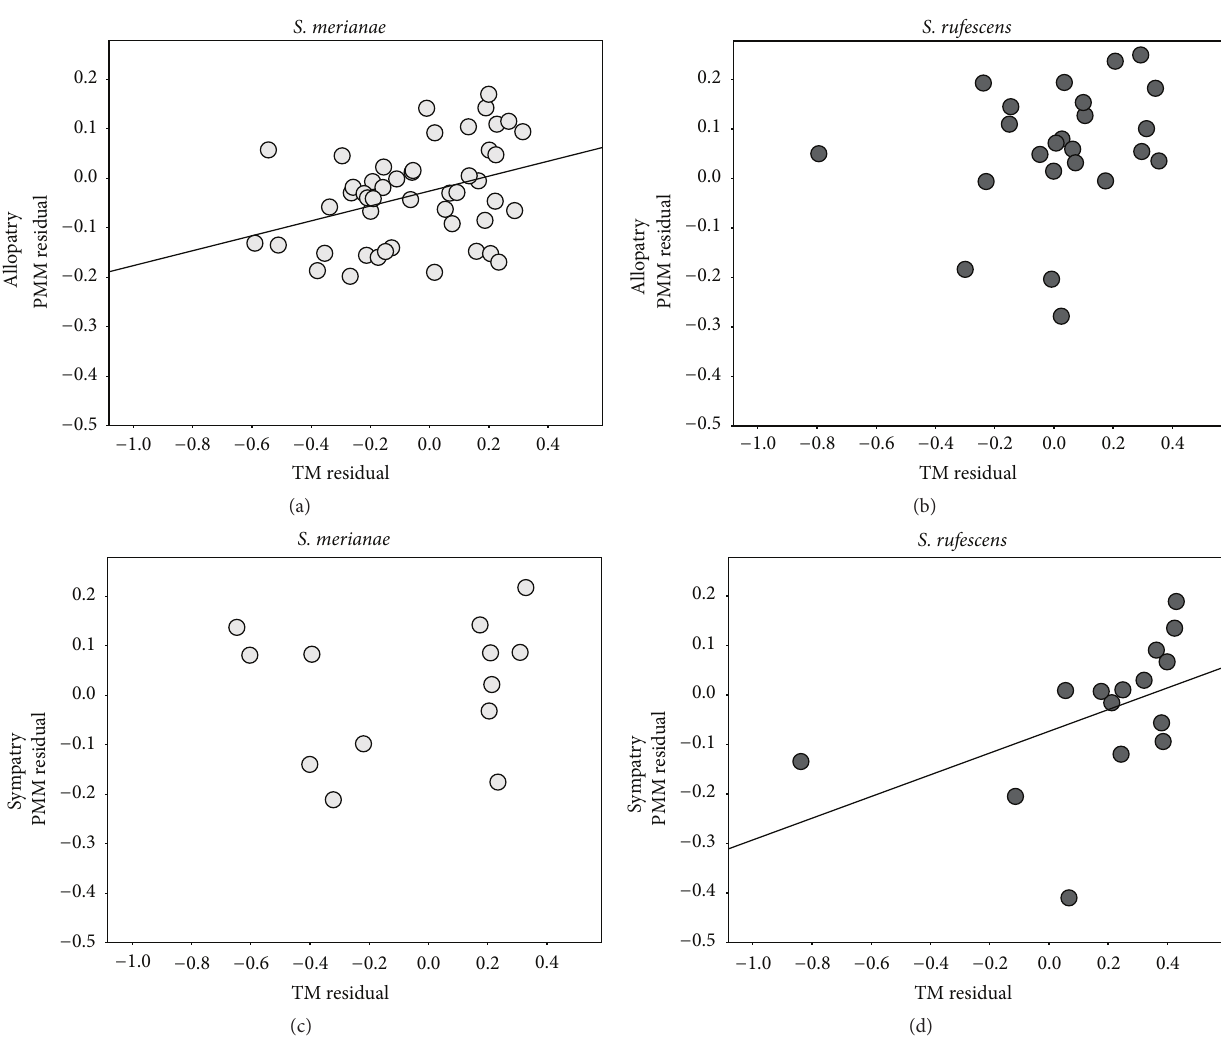
Figure 1: Relationship between testes investment and muscle investment for (a) Salvator merianae in allopatry, (b) S. rufescens in allopatry, (c) S. merianae in sympatry, and (d) S. rufescens in